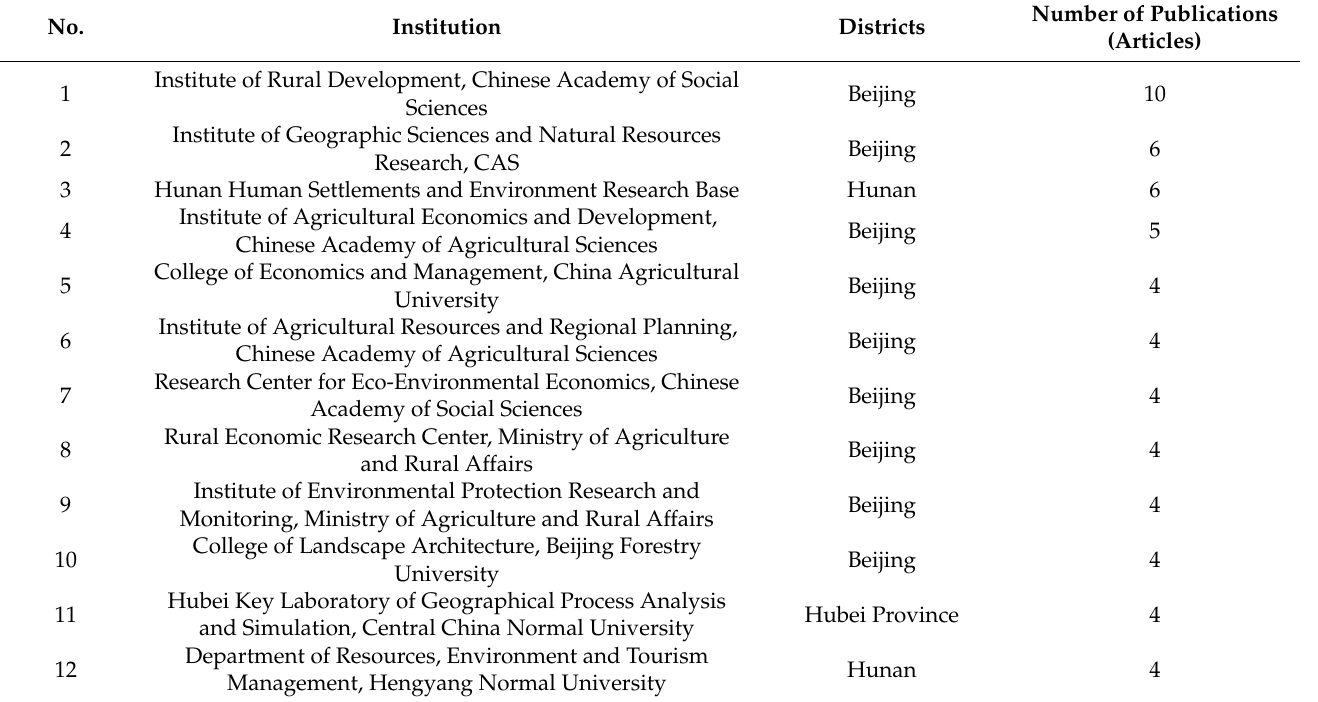
Table 2. Statistics on the distribution of research institutions’ publications on rural human